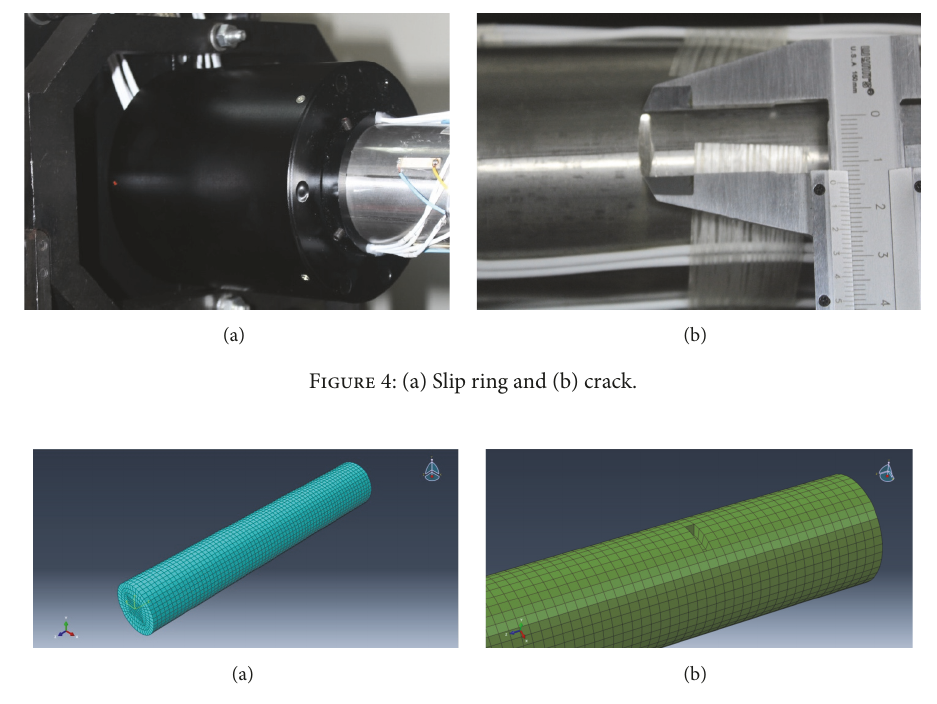
Figure 5: (a) FEM model of rotor and (b) FEM model with crack simulated by deleting